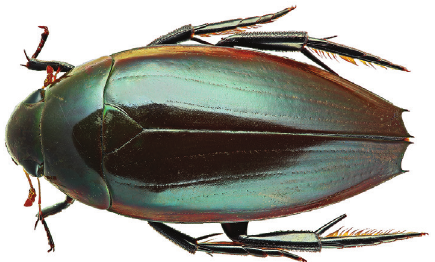
Figure 25. Hydrophilus aculeatus (Solier, 1834) 37.0 mm, iSimangaliso Wetland Park, Eastern Shores (site 14), February 2015 DT Bilton, MS Bird & R Perissinotto leg.